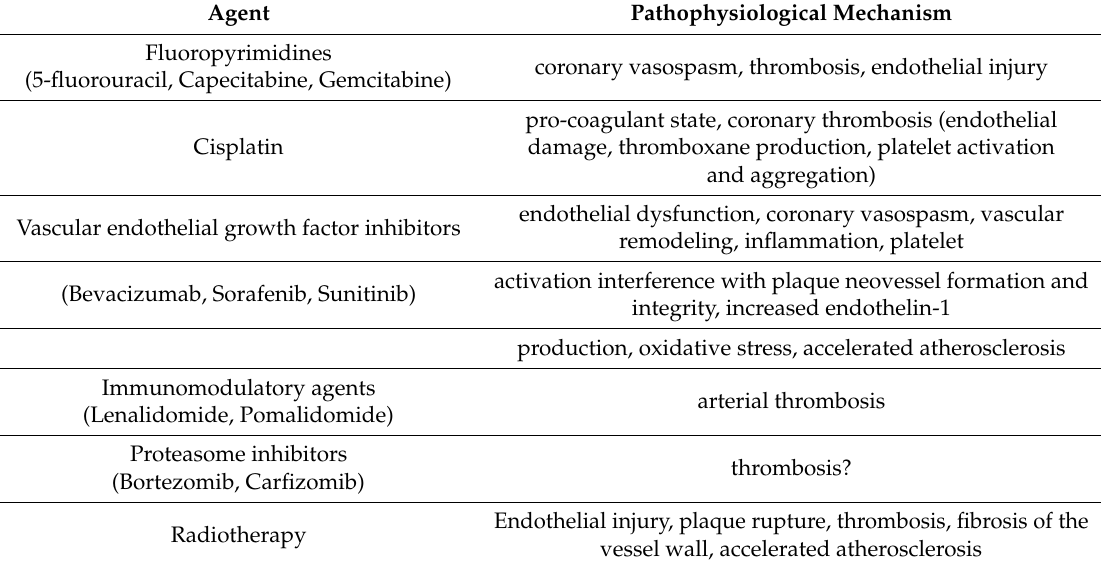
Table 1. Cancer treatments more frequently associated with acute coronary syndromes and their established or proposed pathophysiological